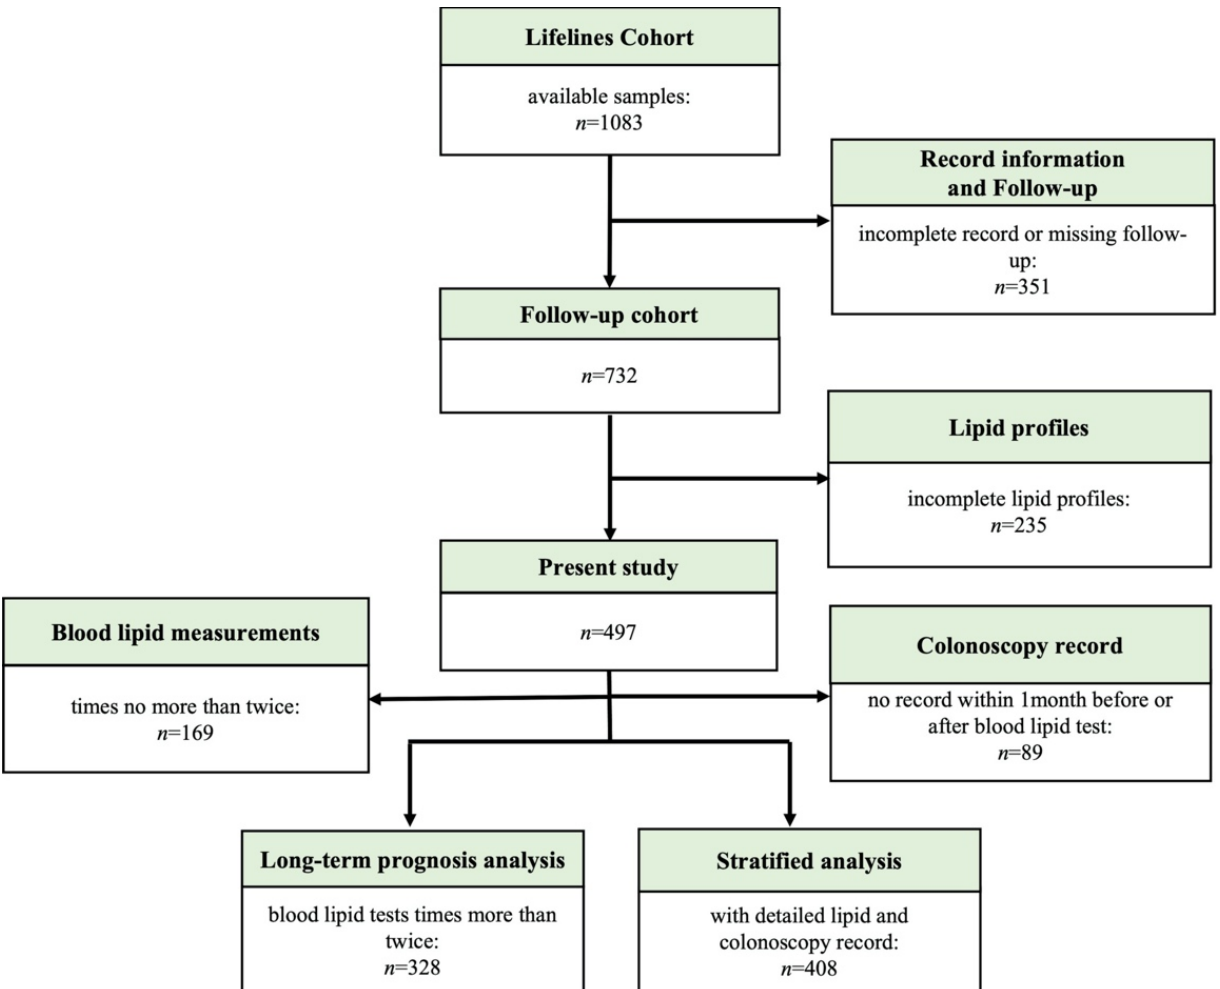
Figure 1. Flowchart of cohort participant inclusion.